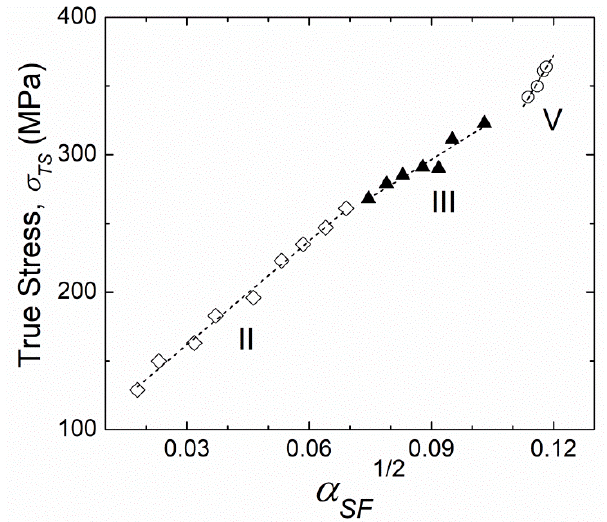
Figure 9. True applied stress, σ TS , vs. the square root of stacking fault probability, α SF 1 / 2 , for nc-Ag plastically deformed in Regimes II (◊), III ( ▲ ) and V ( ○ ), respectively. Dashed straight lines represent linearly fitted data.